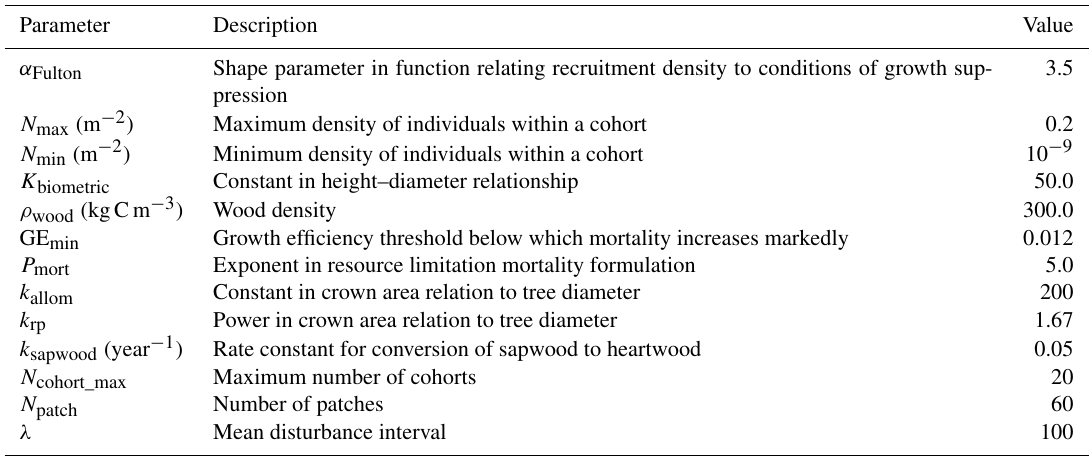
Table A2. POP parameters.